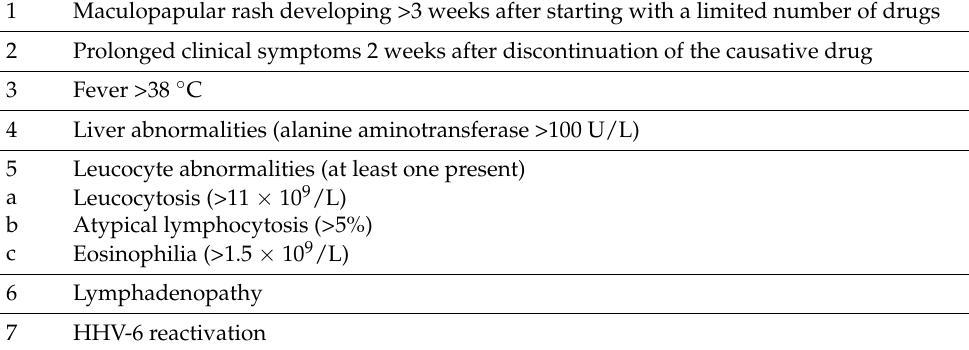
Table 2. Diagnostic criteria for drug-induced hypersensitivity syndrome (DiHS) established by the Japanese Consensus Group ***